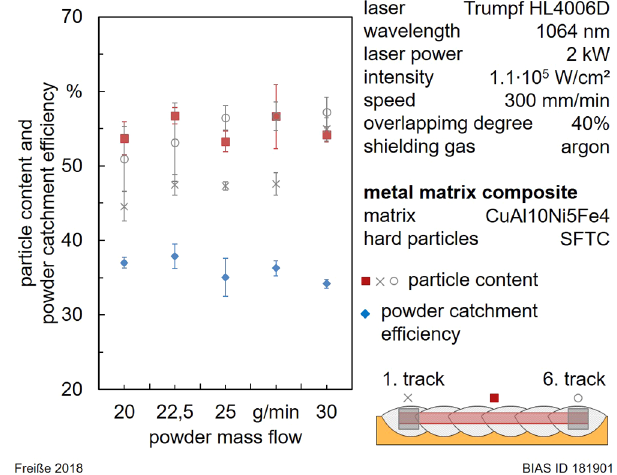
Fig. 4. Three-dimensional laser-scanning confocal microscope image and pro fi le cuts of the MMC surface machined by die- sinking EDM.